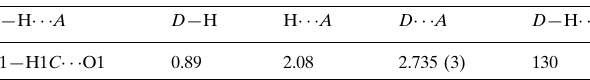
Hydrogen-bond geometry (A˚ , (cid:2) ). D —H (cid:1)(cid:1)(cid:1)